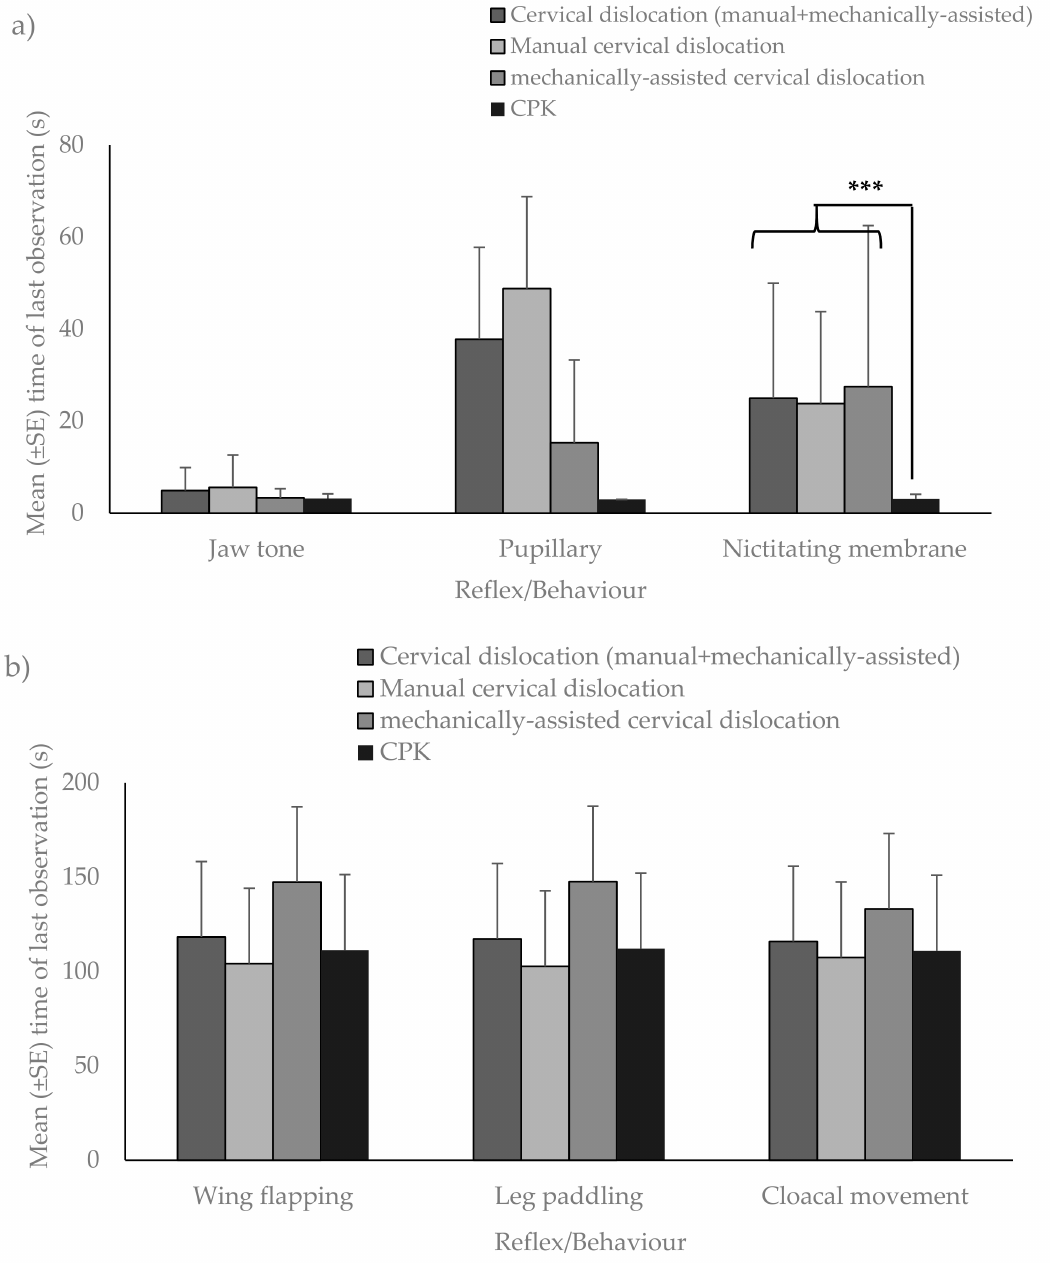
Figure 4. Comparison of mean ( ± SE) times of last observations for ( a ) jaw tone, pupillary, and nictitating membrane; and ( b ) wing flapping, leg paddling, and cloacal movement post successful method application for all killing methods. Asterisks (*) indicate that there was a significant difference between groups (*** = p <